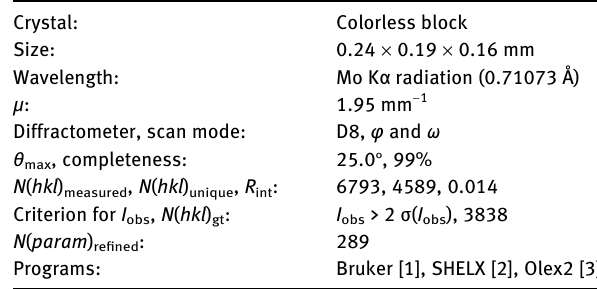
Table  : Data collection and